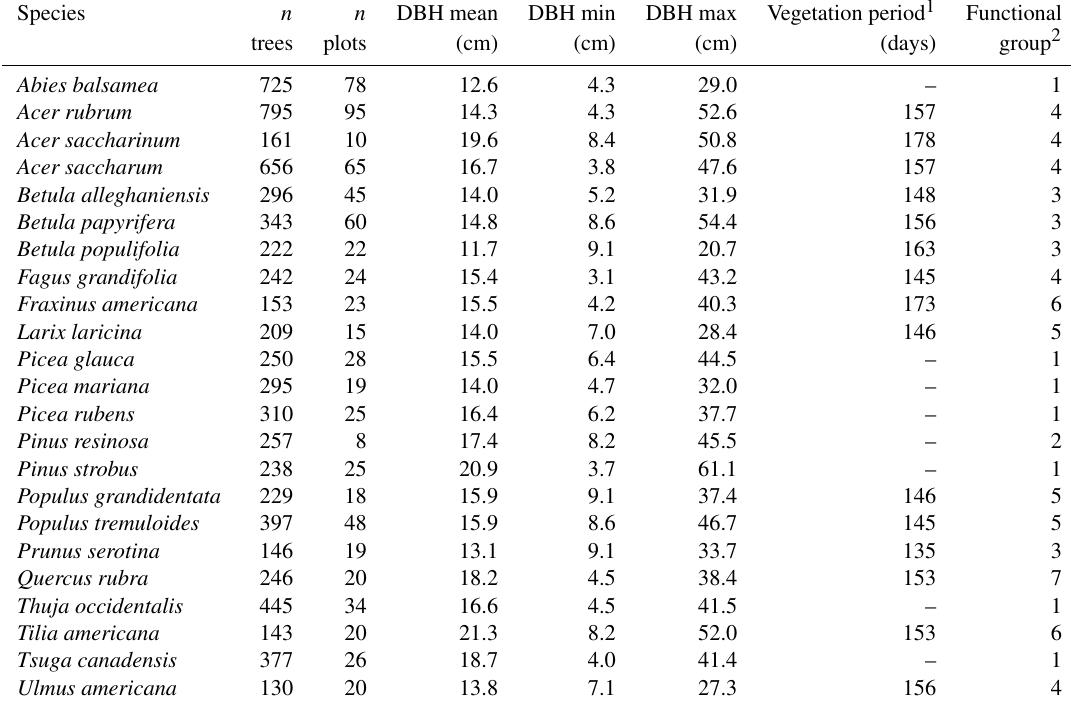
Pinus resinosa 257 Pinus strobus 238